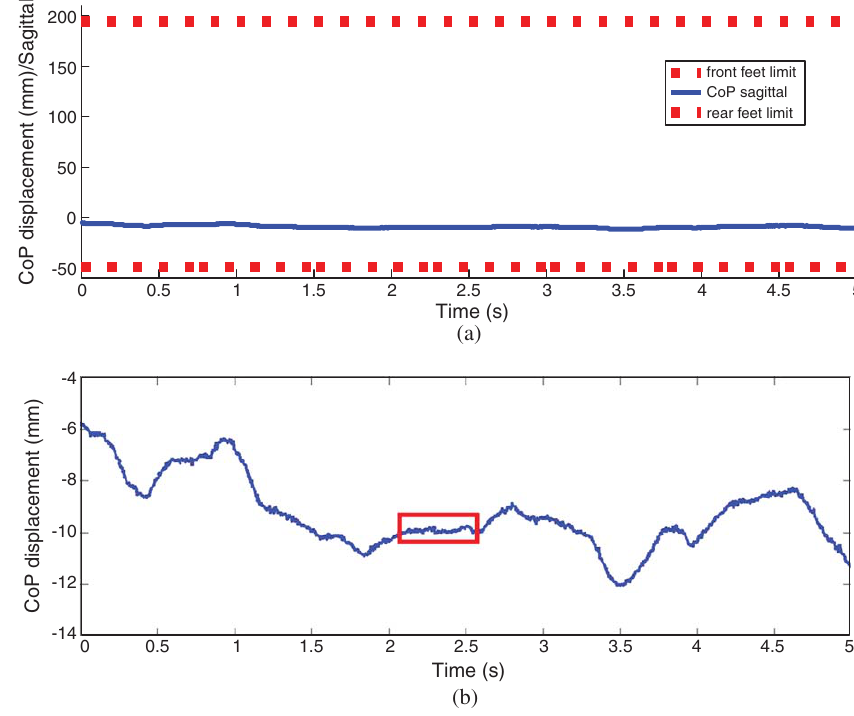
Fig. 5. Static period tracking. (a) CoP position recorded while the subject is maintaining a static position. (b) Enlarged signal view: the red box indicates the period considered for the SESC